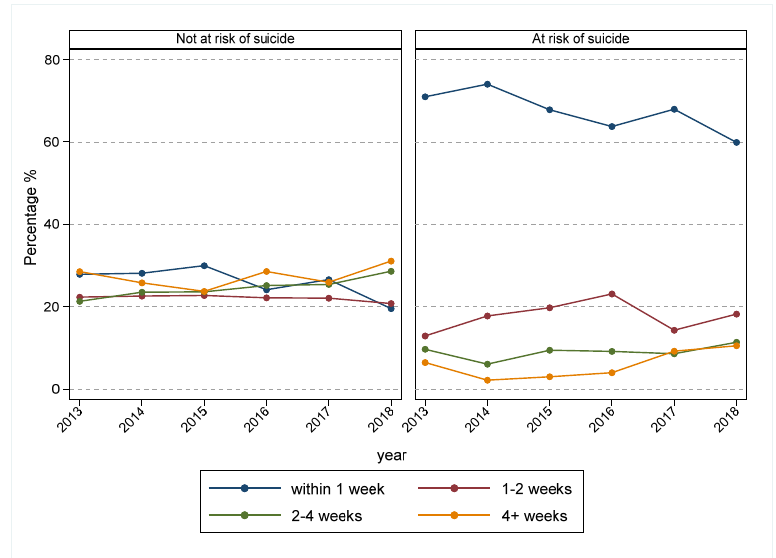
Figure 4. Trends in workforce capacity and patients per health care practitioner, Western Sydney Primary Health Network, 2013–2018. We excluded 2113 referrals, received from July 2016 to 31 De- cember 2018, for 2082 clients (explained in the Supplementary Materials) due to the unavailability of HCP-identifiable information. However, de-identified HCP identifier information is available in the PMHC MDS for these excluded referrals, but there may be multiple HCP IDs for the same HCP given by different PMHC service provider organization levels if any HCP works in multiple PMHC service provider organizations.